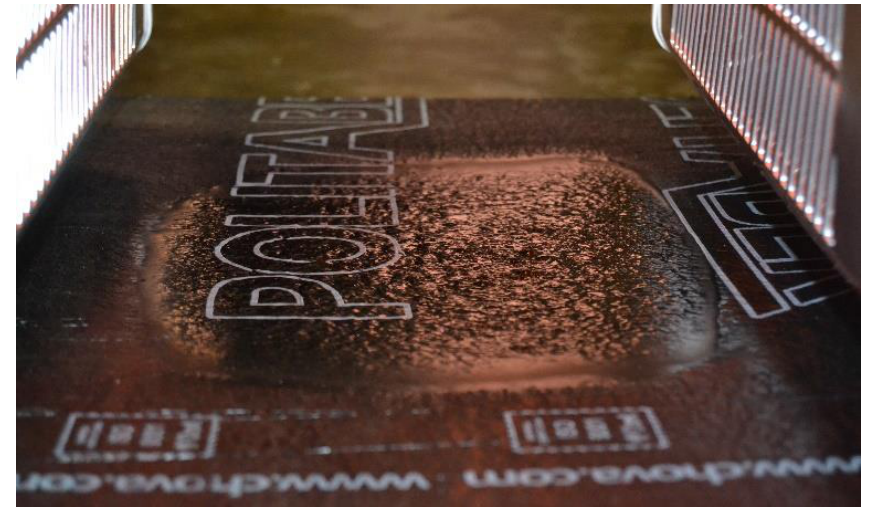
Figure 15. Footprint of the surface heated up.